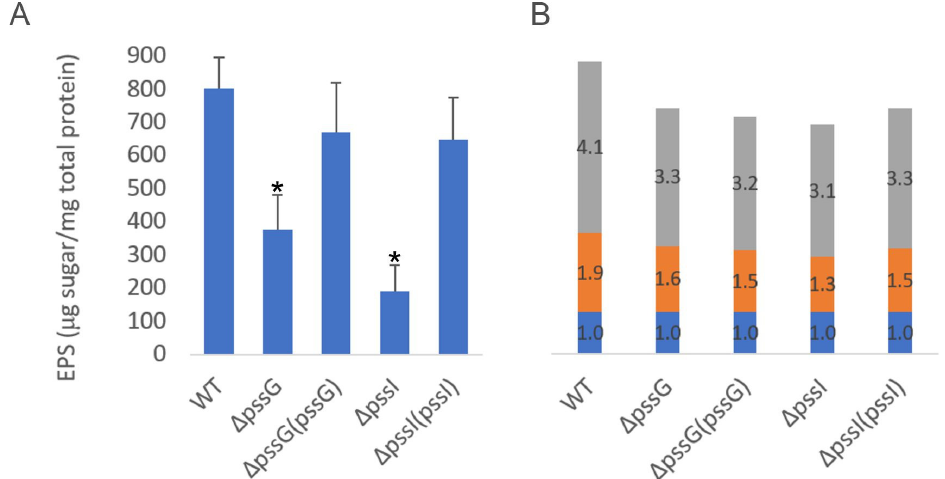
Figure 10. Analyses of exopolysaccharides produced by ∆ pssG , ∆ pssI , and their complemented derivatives. ( A ) The amount of total sugar in tested samples was determined based on the calibration curve prepared for the glucose solution and was expressed as the total sugar content ( μ g) per total protein of bacterial cells from the same culture sample (mg). Bars represent the mean values of four independent experiments with two technical repeats each. Error bars represent standard deviation. Asterisks (*) mark bars representing amounts significantly different than produced by the WT strain ( p < 0.01). ( B ) Glycosyl composition analysis was performed by combined gas chromatography-mass spectrometry (GC/MS) of alditol acetates. Proportions of glucose (gray bars), glucuronic acid (orange bars), and galactose (blue bars) are shown. Bars represent the averaged duplicate results. In the case of the pssI gene, a complemented derivative Δ pssI ( pssI ‐ lc) was analyzed.